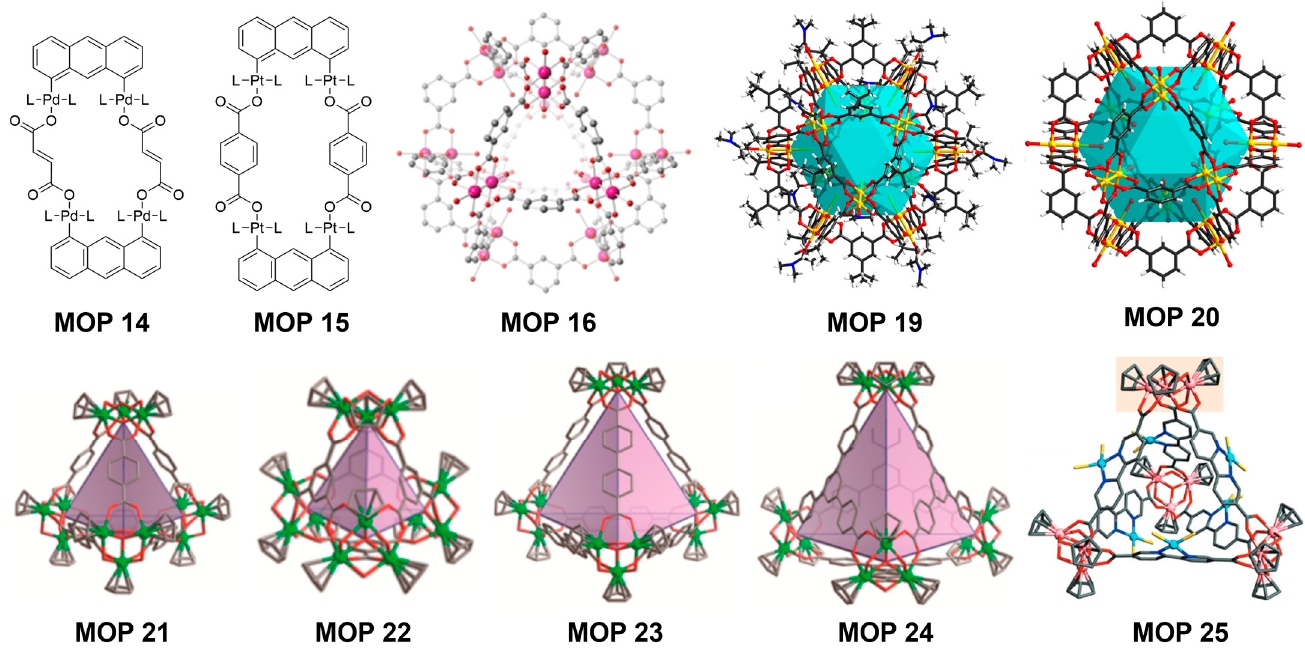
Figure 10. O-donor based MOPs prepared using second row transition metal ions. Chemical structures of Pd-based MOP 14 and MOP 15. Crystal structures of Rh-based anticubooctahedron MOP 16 and Ru-based two cuboctahedron cages, MOP 19 and MOP 20. Crystal structures of Zr IV -based tetrahedron MOP 21, MOP 22, MOP 23 and MOP 24 are shown. MOP 25 is the crystal structure of Zr-bpydc-CuCl 2 . Reprinted by permission from Refs. [116–121]. Copyright 2009 from Royal Society of Chemistry. Copyright 2003, 2013, 2016 from American Chemical Society. Copyright 2016 from Wiley-VCH. Copyright 2015 from Elsevier.